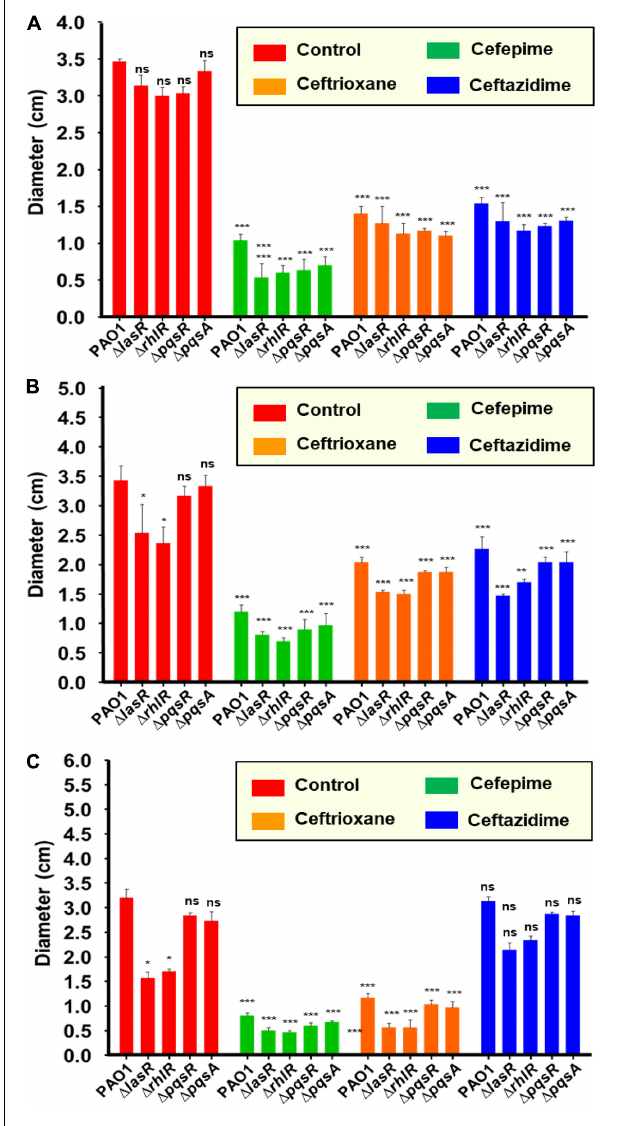
FIGURE 4 | Quantification of motility inhibition (diameter of motility zones) of Pseudomonas aeruginosa by cephalosporins: Comparative analysis of the diameter of the motility zone (mm) for PAO1, (cid:49) lasR, (cid:49) rhlR, (cid:49) pqsR and (cid:49) pqsA in presence of CP (A) , CF (B) and CT (C) . Not significant (ns): p > 0.05, * p ≤ 0.05, ** p ≤ 0.01, *** p ≤ 0.001.